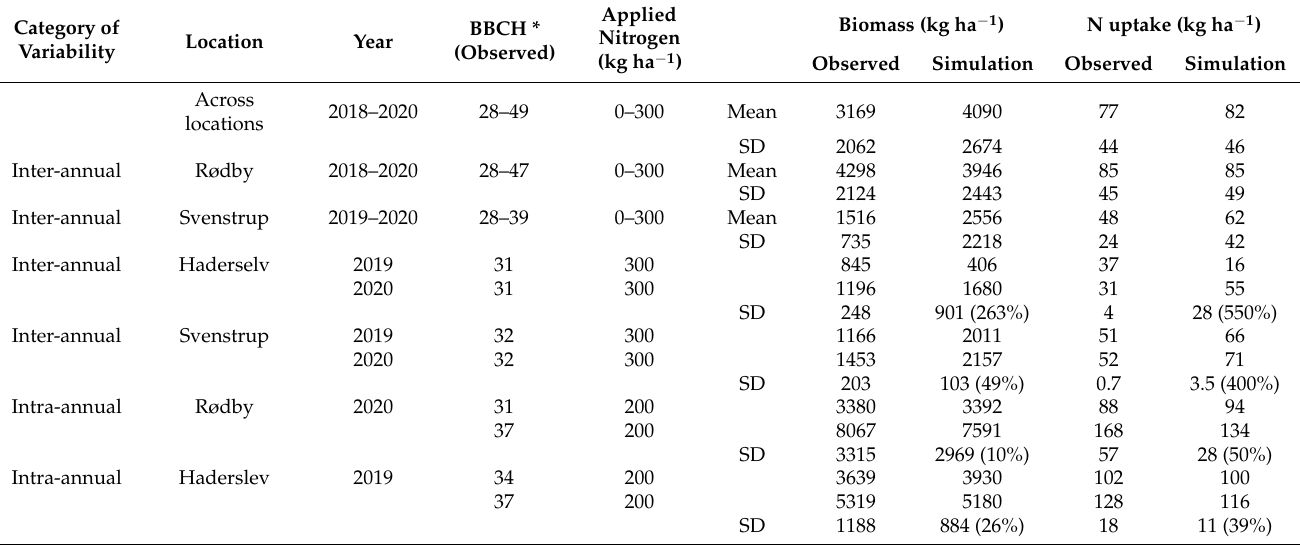
Table 2. Inter- and intra-annual variability of simulated and observed biomass and N uptake. SD represents standard deviation. In parenthesis are percentages of the difference between SD of simulated and observed data over the observed